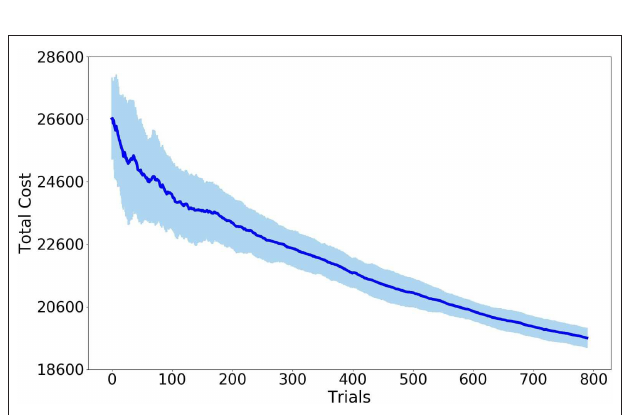
FIGURE 7 | Cartesian trajectory for reproduction of demonstrated trajectory with and without obstacle.